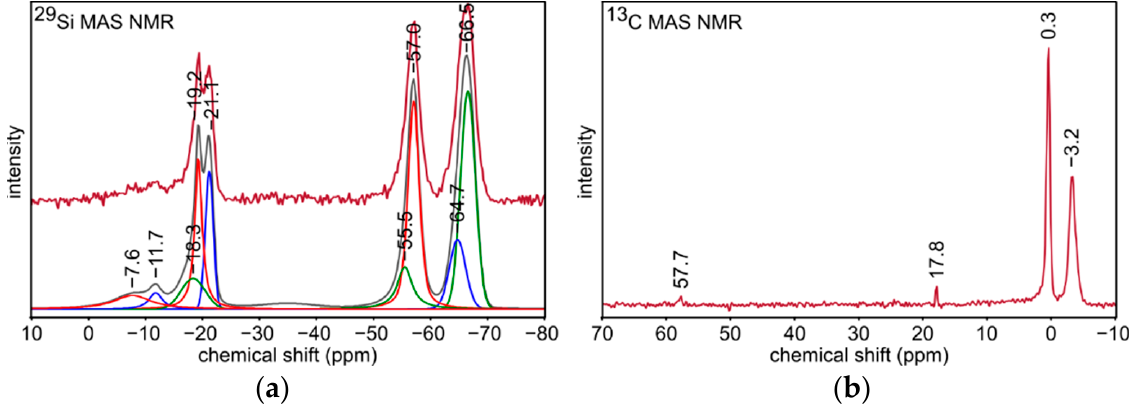
Figure 3. ( a ) 29 Si and ( b ) 13 C MAS NMR spectra for S2 sample. 29 Si MAS NMR spectrum for S4 sample (Figure 4a) indicates its complex structure.